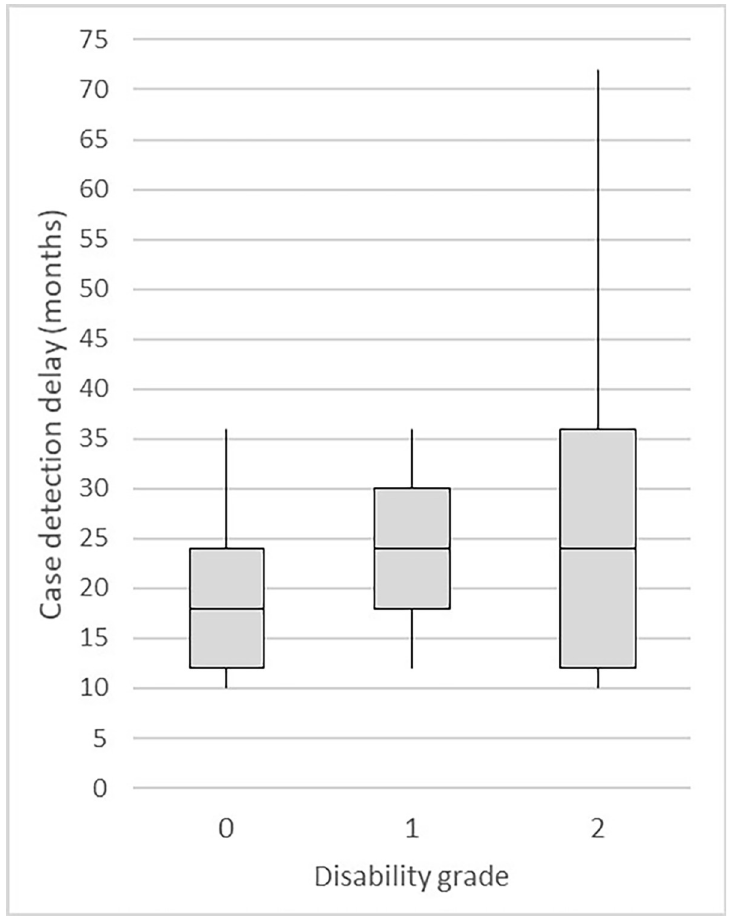
Fig 3. Case detection delay in relation to the disability grade at the moment of diagnosis, leprosy patients in Ethiopia, Sample 5 (n = 49).